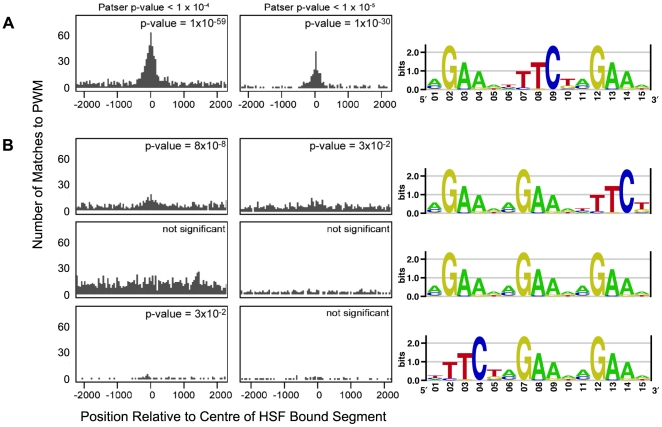
The 5 bp motif nGAAn arranged as direct inverted repeats is enriched in HSF-bound segments.We used the pattern-matching program Patser [38] to score the occurrences of 4 PWMs from TRANSFAC (M00165, M00164, M00167, M00166), depicted as sequence logos on the right side of the figure, in both the sequence bound by HSF and the local background (up to 2500 bp on either side of the peak of each HSF binding site). The histograms show the number of matches to each PWM in 50 bp windows centered on the peak of each HSF-bound segment. P-values at the top of each column of graphs indicate the cut-off used when considering a match by Patser. P-values at the top right of each histogram indicate the probability given by a X2 test that the difference in the number of matches to the PWM found in the sequence at the peak and in the local background is due to chance. (A) The motif nGAAnnTTCnnGAAn shows significant enrichment at the peak of the HSF-bound regions at both Patser p-value cut-offs (compare left and right columns) and occurs more frequently than any other orientation of this motif in HSF-bound regions (compare A and B). (B) Other orientations of the 5 bp core motif not as significantly enriched as the motif in (A), if at all, in the HSF-bound segments. What little enrichment is seen for the alternate orientations when the Patser p-value cut-off is set to <1×10−4 (left column) is essentially lost when the Patser p-value cut-off is lowered to consider only highly probable matches (p-value<1×10−5, right column). Sequence logos were generated from TRANSFAC PWMs M00165, M00164, M00167, M00166 using the online web tool enoLOGOS [72].